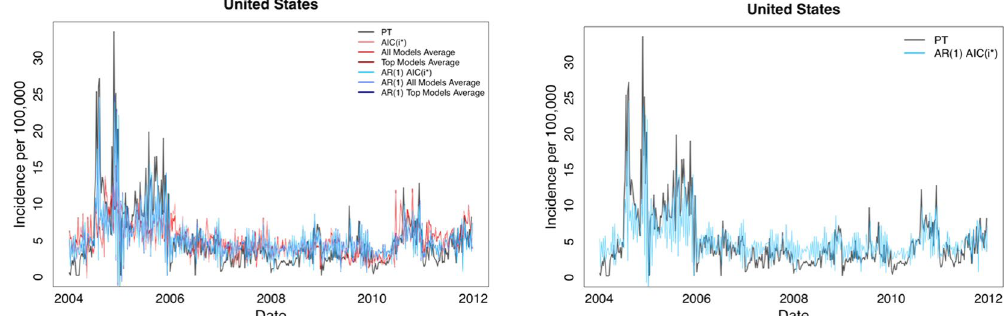
Figure 2. Time-series graphs showing PT pertussis incidence (black) per 100,000 people as a function of year for national U.S. data for 2004–2011. The left panel shows the results of all 6 modeling methods (see text), and the right panel shows the optimized AR(1) AIC ( i ) model. The accuracy of this model supports * previous findings that in larger geographic regions such as California 23 and Australia 24 , GT models can track incidence. Some state-level models may be less accurate because they expose new sources of cultural and sociodemographic variability that are inconsequentially combined in the national model. Abbreviations: PT: Project Tycho, AIC ( i ): lowest AIC model, All Models Average: average of 2 n − 1 models using posterior *